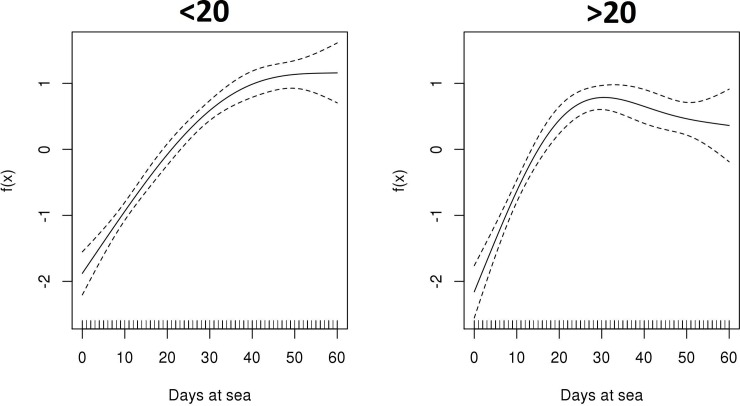
Functional shapes of the non-parametric relationship between tuna biomass and days at sea with 95% confidence intervals (dashed lines), according to the depth category of the object.